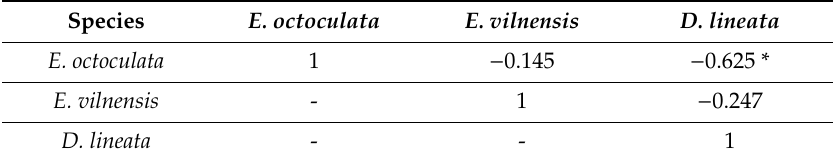
Table 5. Pearson’s correlation coe ffi cients among pairs of